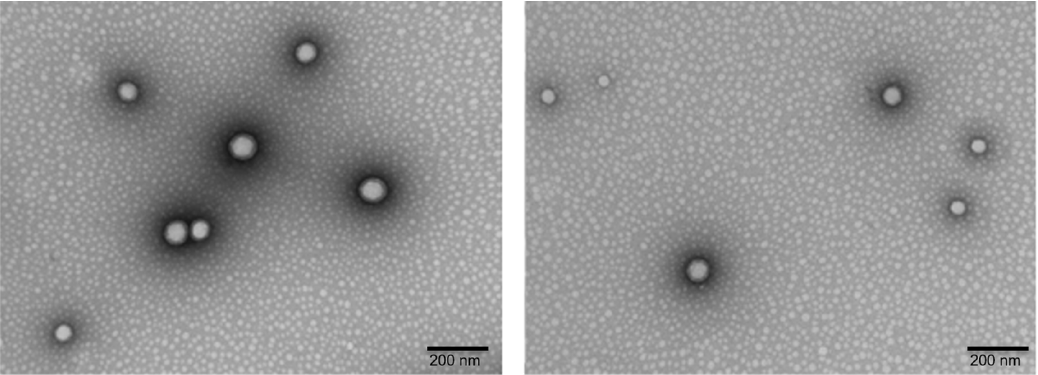
Figure 2. TEM images of PGZ ‐ NPs in suspension before spray drying.